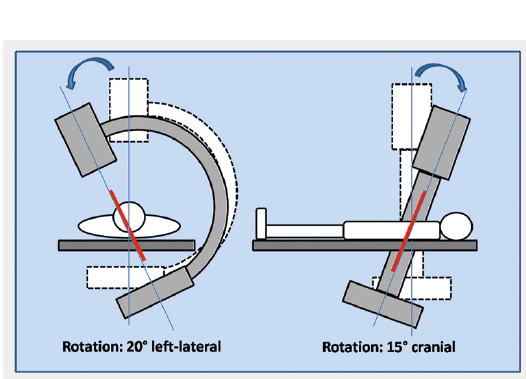
Preoperative CT-scan reconstruction of the aortic root. On the upper right side, two angles indicate the positioning of the aortic valve plane in the space and the fluoroscopy is orientated consequently (in this case, the angles are 21 degrees left-lateral and 16 degrees cranial).